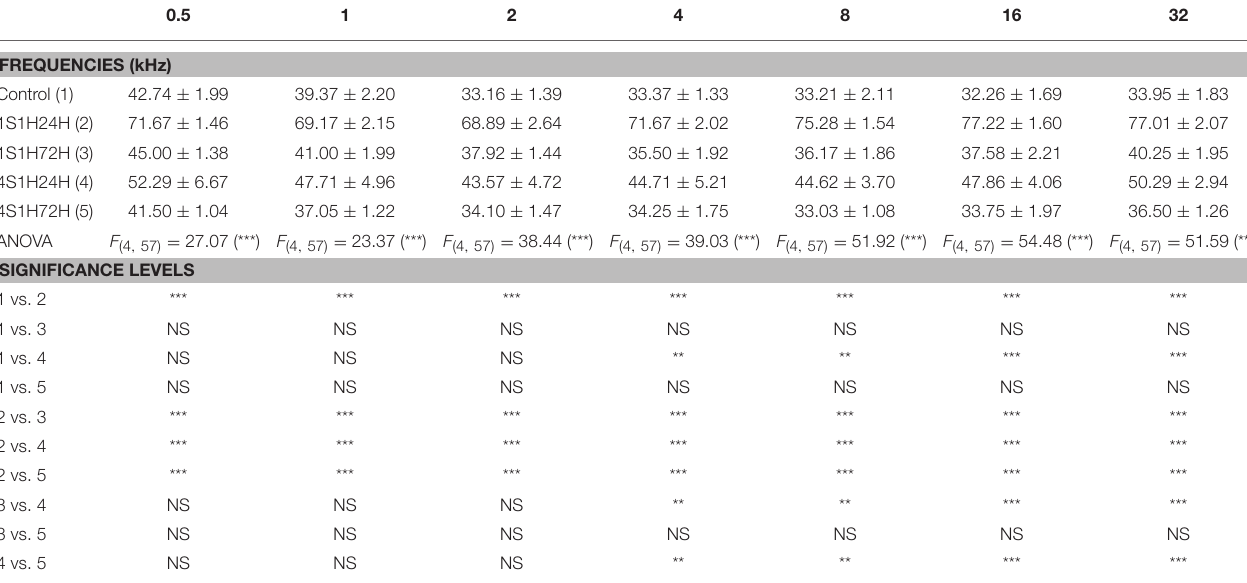
TABLE 2 | ANOVA analysis of the interaction between the time post-exposure and the auditory